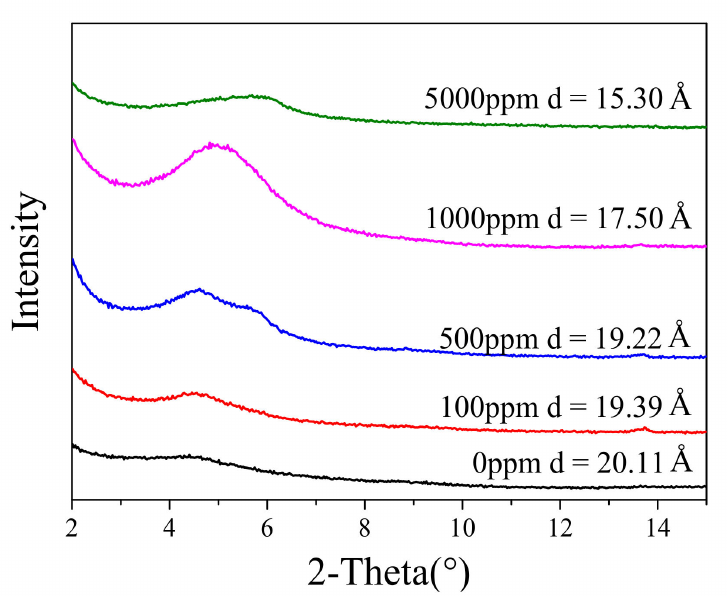
Figure A1. The d-spacing of wet Na-bent under the action of C 8 -OMImBF 4 at different